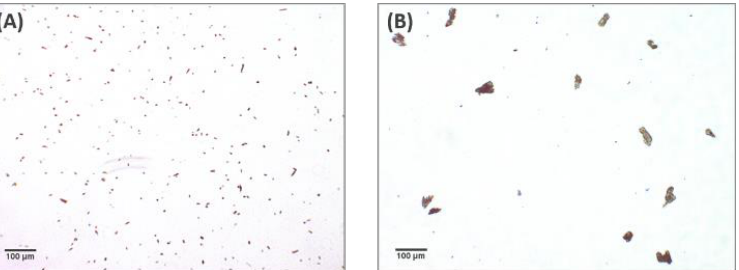
Figure 3. Optical microscopic examination of 18 mg/mL HA non cross-linked dermal filler containing 0.01% CaHA after staining with Toluidine Blue 1%. ( A ) Magnification 4×; ( B ) magnification 10×. Cohesivity is a parameter of recent interest, indicating the ability of a gel to with- stand stress in physiological conditions [1]. Different methods exist to evaluate cohesivity, with the Gavard–Sundaram Cohesivity Scale being one of the most used. The related scale is shown in Figure 4